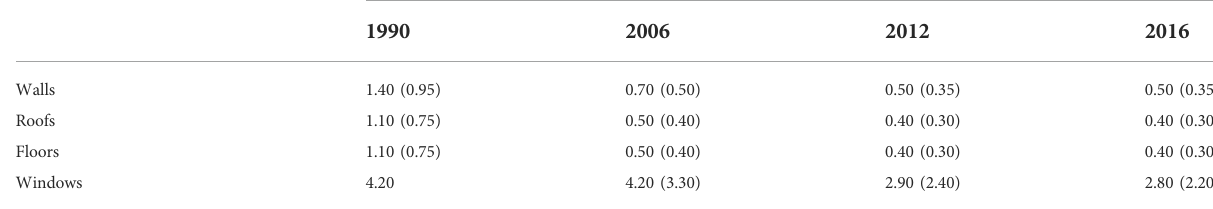
TABLE 3 U-values (W/m2K) in the Portuguese building regulation in Lisbon and Bragança (Fragoso and Baptista, 2016). Envelope